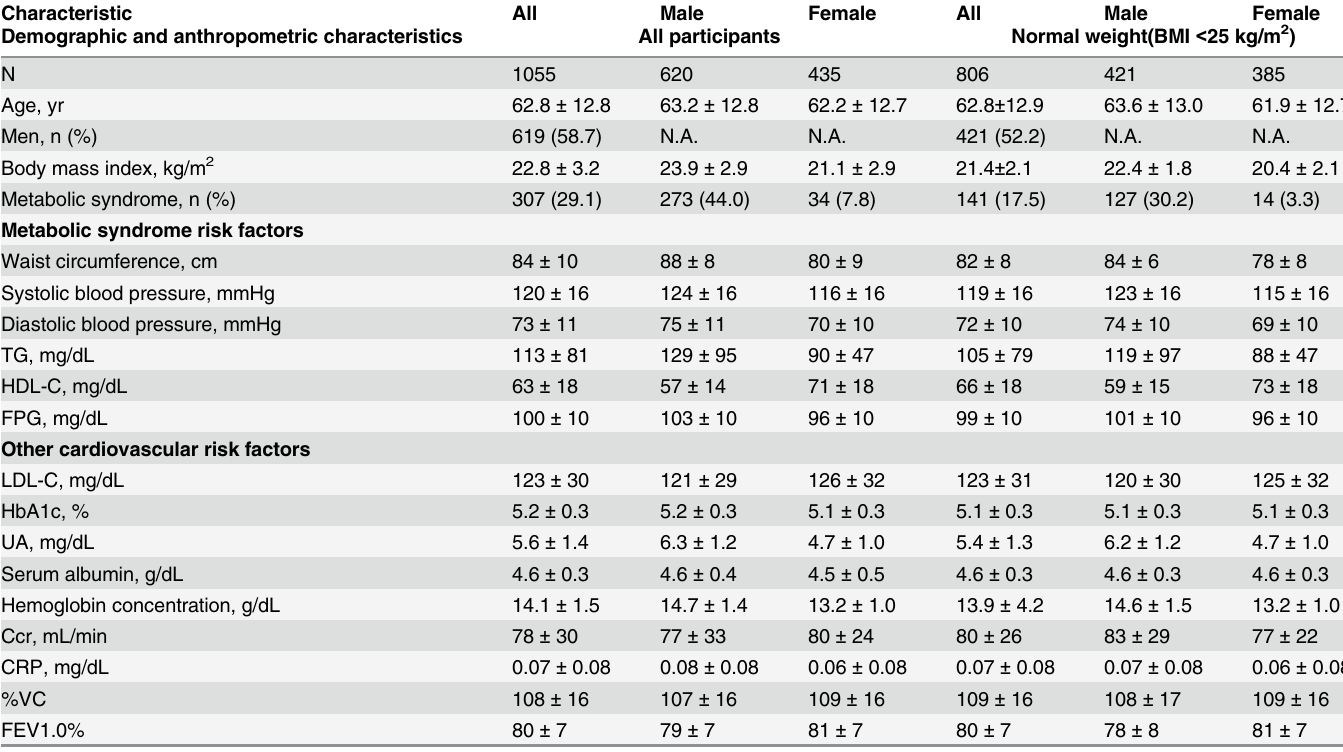
Table 1. Baseline